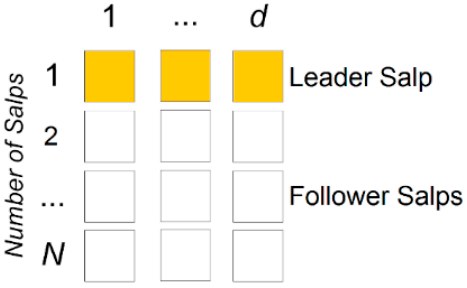
Figure 7. Population of the salp swarm algorithm.